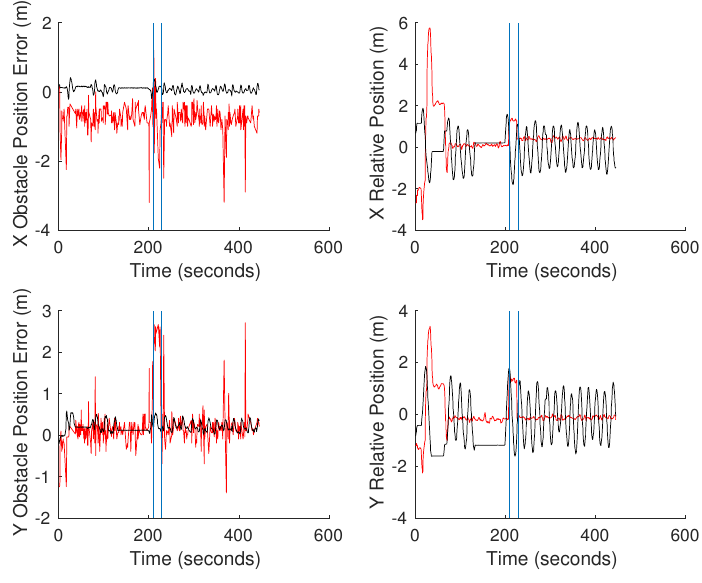
Figure 13. Continuous obstacle position test conducted with the Piksi Multi. Red shows the data associated with the UAV, while black is the data for the UGV. The vertical blue lines indicate the period of time where the RTK GPS on the UAV